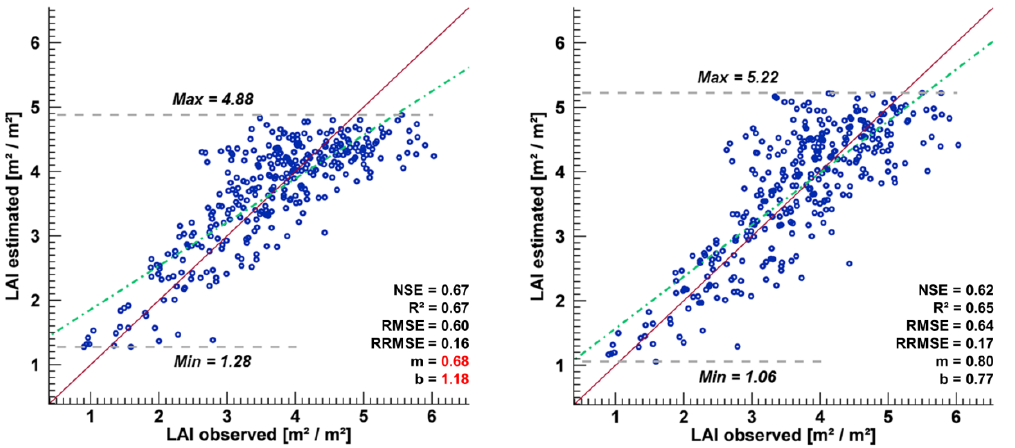
Figure 5. Correlation of observed and estimated LAI. ( Left ) The scatter plot is based on the LUT criteria setting (Laplace/median, n = 700, σ = 9%, inverse-multiplicative noise), which resulted in the highest accuracy according to NSE; ( Right ) The scatter plot is based on the highest accuracy after applying the slope/intercept rejection threshold ( n = 350, σ = 4%).